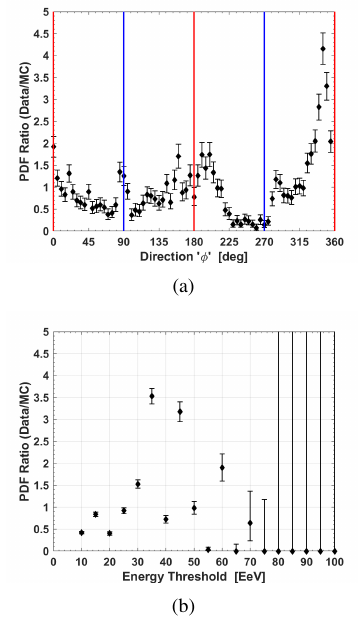
Figure 8. PDF ratio plot of scanned parameters. (a) Wedge pointing direction parameter, φ . Blue lines are perpendicular to the SGP and red lines are parallel. (b) Energy threshold, E . The three largest deviations are at 35 EeV, 45 EeV, and 60